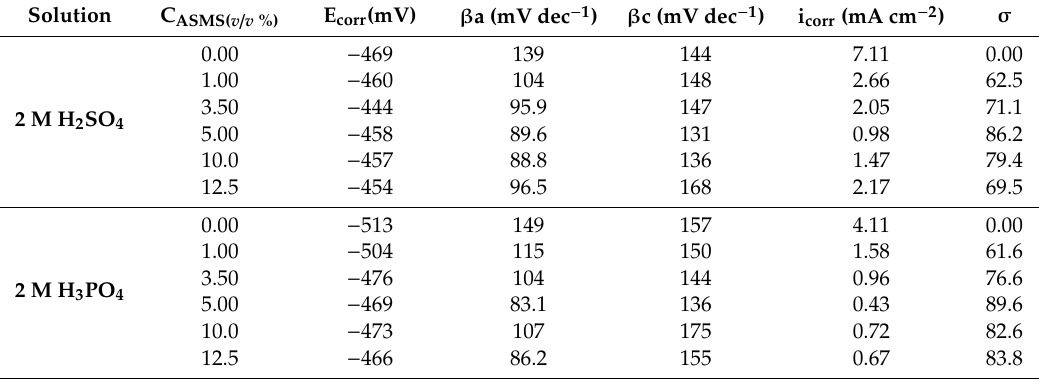
Table 2. Electrochemical Tafel polarization parameters in the presence of various concentrations of